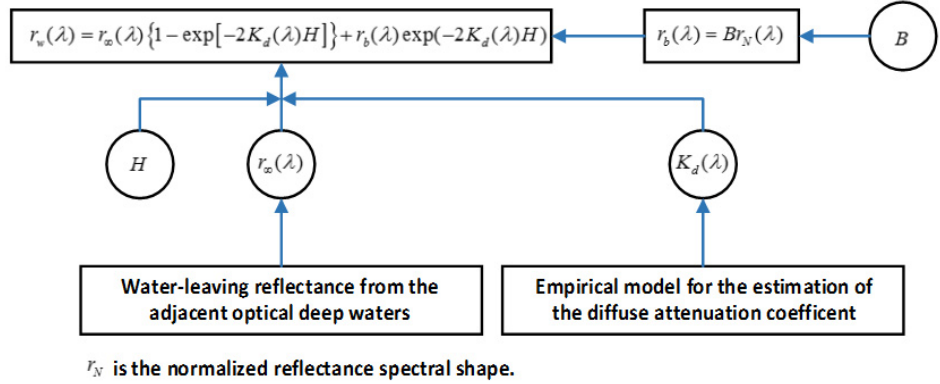
Figure 2. The bathymetric model used by Hu et al. [37]: B is bottom albedo and r N ( λ ) is reflectance spectral shape normalized at the reference